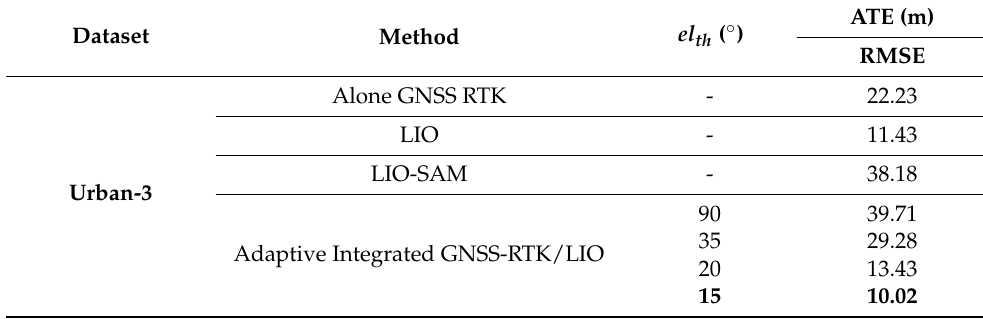
Table 5. ATE of the trajectory estimated by different pipelines on